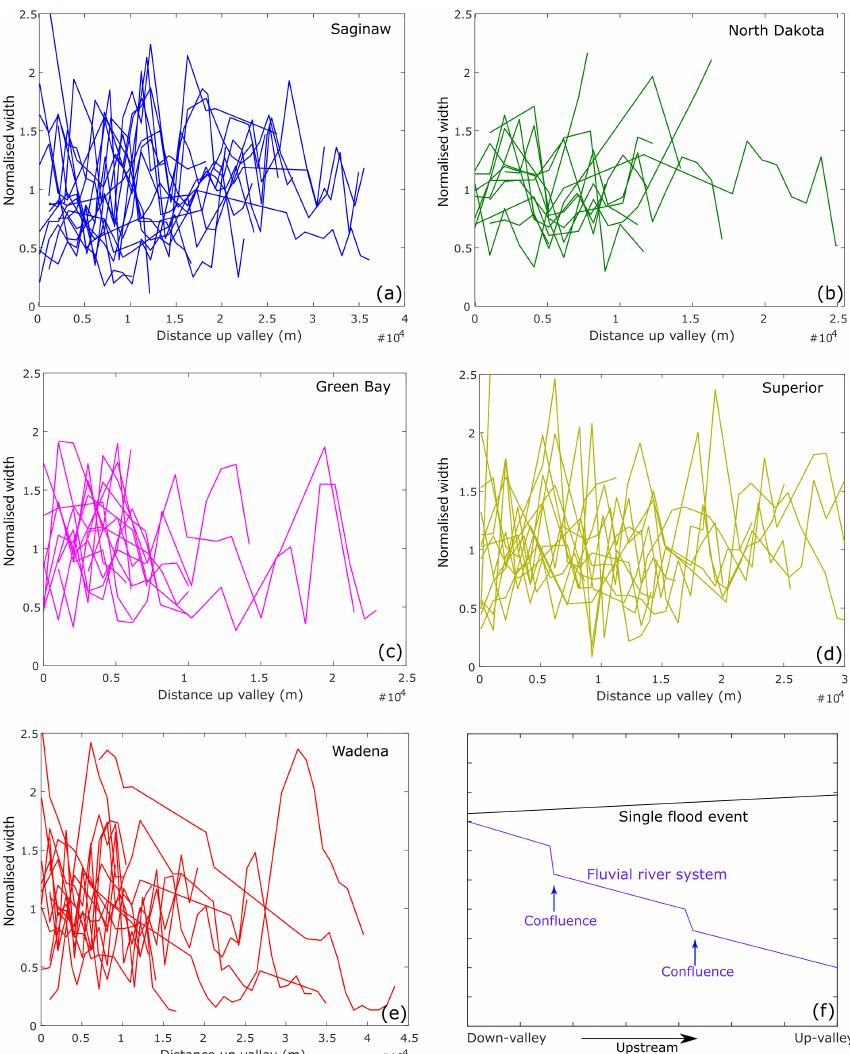
Figure 9. Along-valley plots highlighting normalised (width of tunnel valley at a point/average width of the whole tunnel valley) tunnel valley width variations. (a) Saginaw Lobe; (b) North Dakota; (c) Green Bay Lobe; (d) Superior Lobe; and (e) Wadena Lobe. (f) Cartoon showing the expected relationship between width and distance downstream for a fluvial river (Leopold and Maddock, 1953; Leopold et al., 1964) and single flood event (e.g. Lamb and Fonstad, 2010). Note that the measured tunnel valley width variations conform to neither of these expectations, but instead show variations in width greatly exceeding any possible systematic